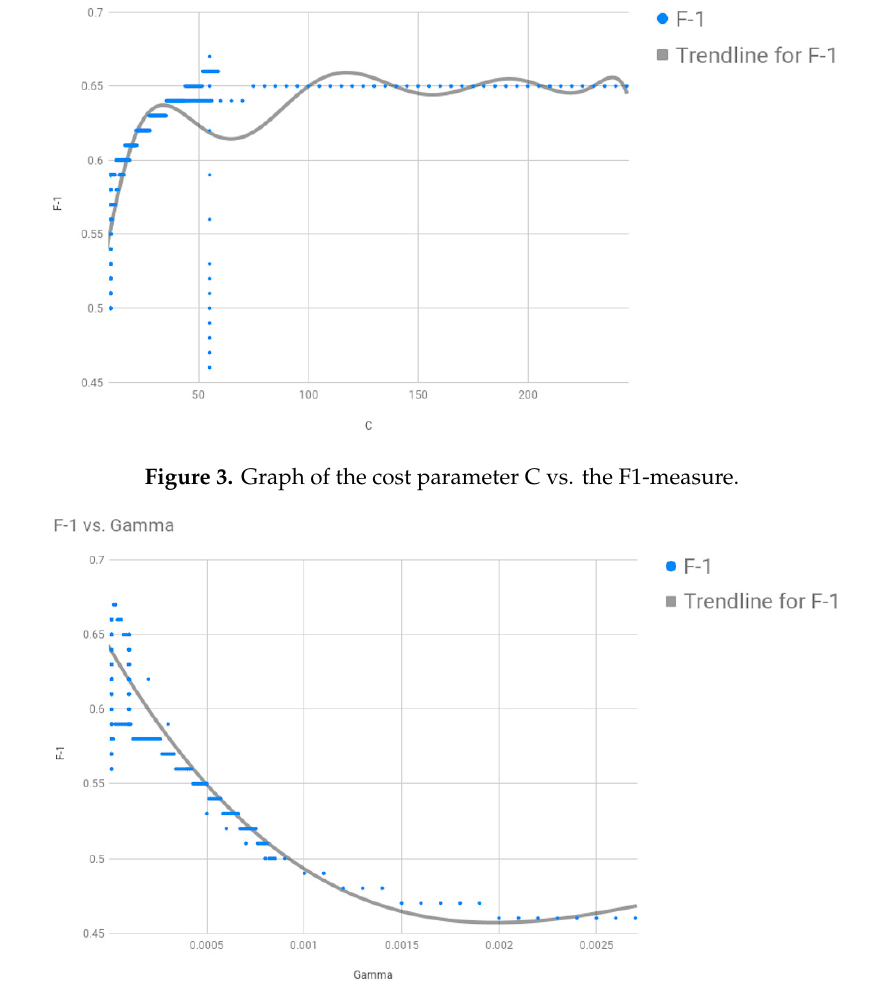
Figure 4. Graph of the gamma parameter vs. the F1-measure for cost C = 75.